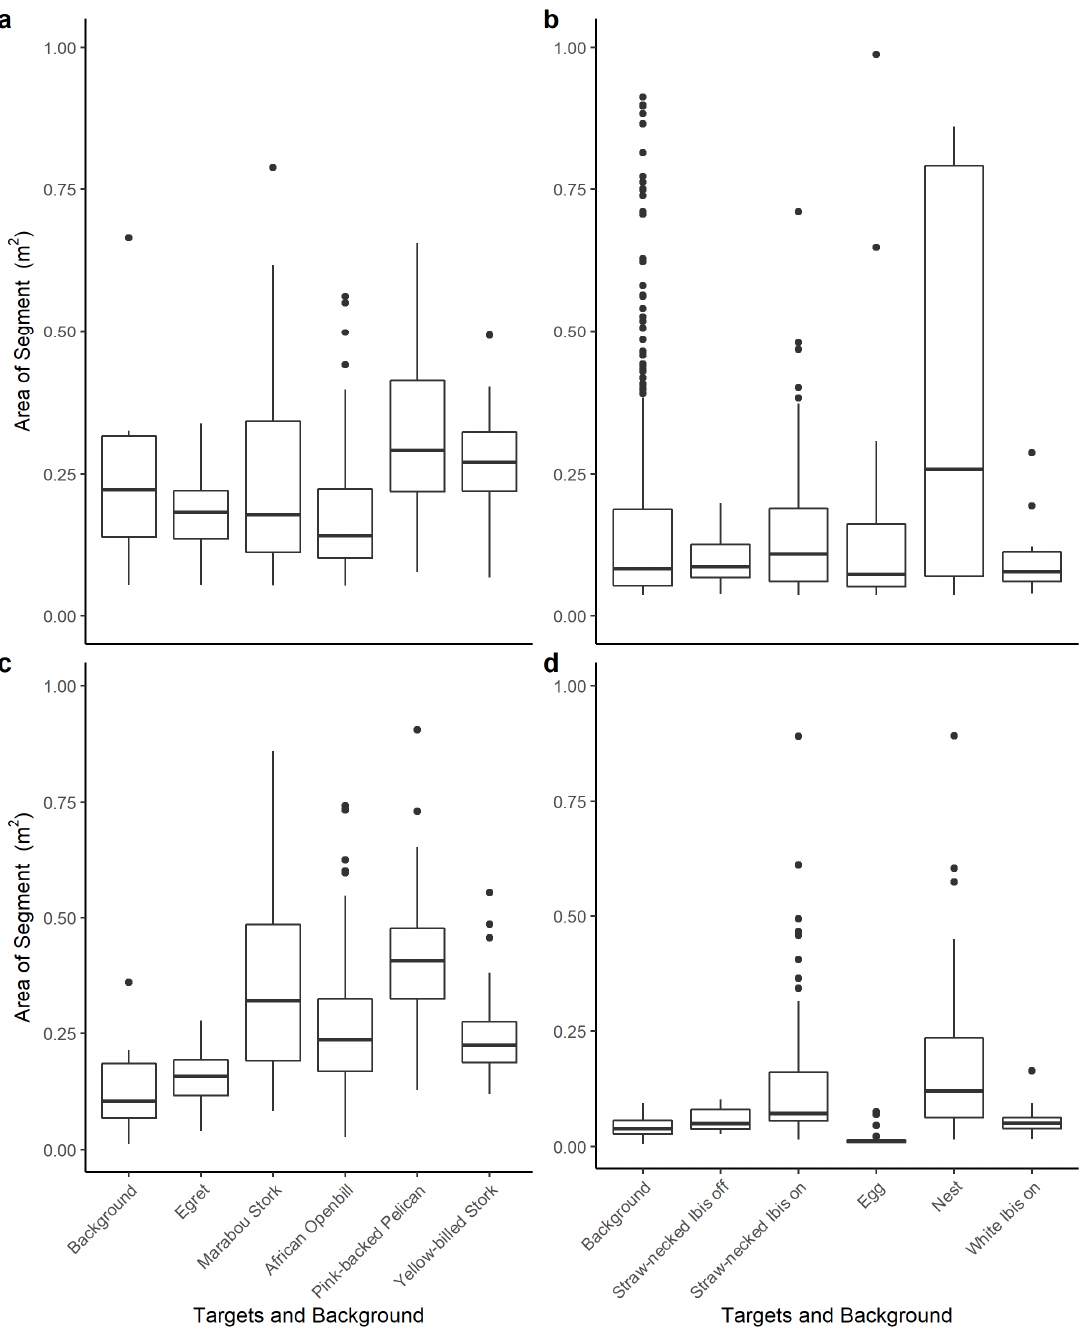
Figure 4. The boxplot used to identify classification errors between segment areas of targets and background using 99% thresholding for the freeware method at ( a ) the Kanana colony and ( b ) the Eulimbah colony, and the payware method at ( c ) Kanana and ( d ) Eulimbah. At the Eulimbah colony, birds were identified as being either on or off their nests.